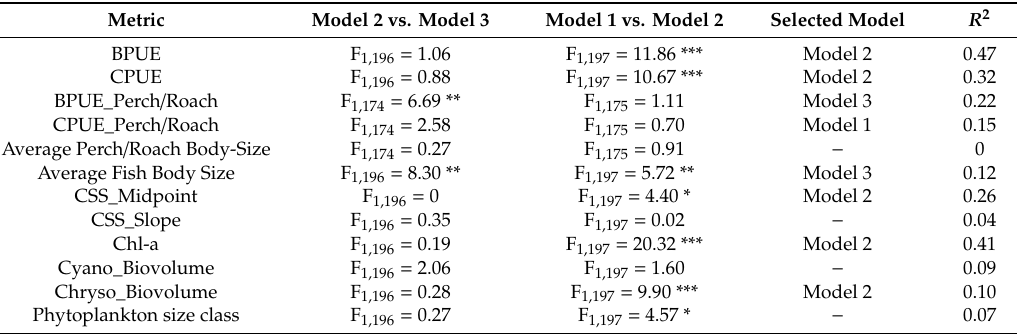
Table 3. Model comparisons two by two (ANOVA) with the final model selected and its associated adjusted R 2 (‘-‘ if the R 2 was lower than 0.1). F-test results: *** p < 0.001, ** p < 0.01 and * p < 0.05. BPUE, biomass caught per sampling unit e ff ort; CPUE, catch per sampling unit e ff ort; CSS, community